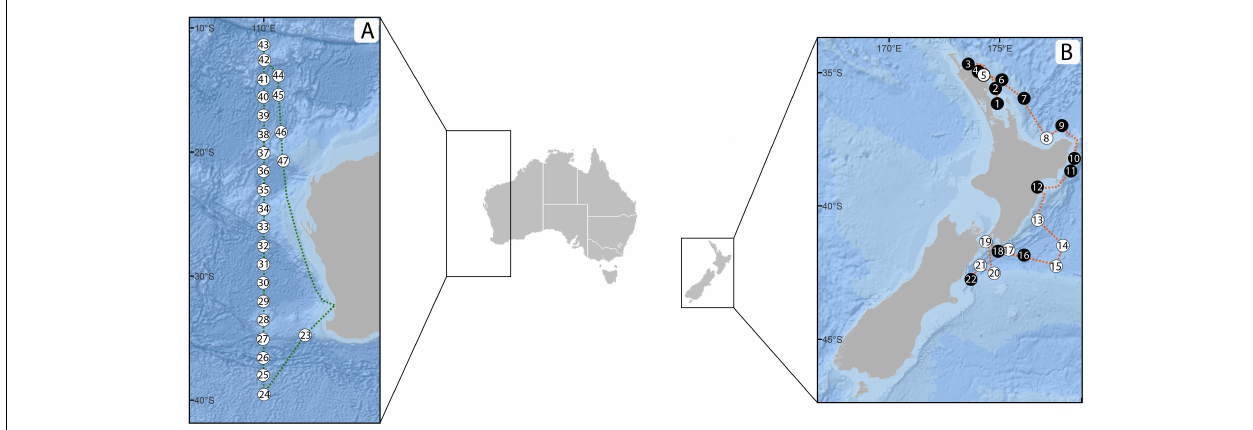
FIGURE 2 | Sampling stations for the (A) Australian case study – RV Investigator voyage IN2019_V03 and (B) New Zealand case study – SSV Robert C. Seamans cruise S284. Numbers correspond to specific sampling stations/dates ( Table 1 ). Black circles, side-by-side sampling using the Traditional Plankton Net (TPN) and Cruising Speed Net (CSN) at 2 knots; white circles, additional and/or unique sampling at 3–5 knots using the